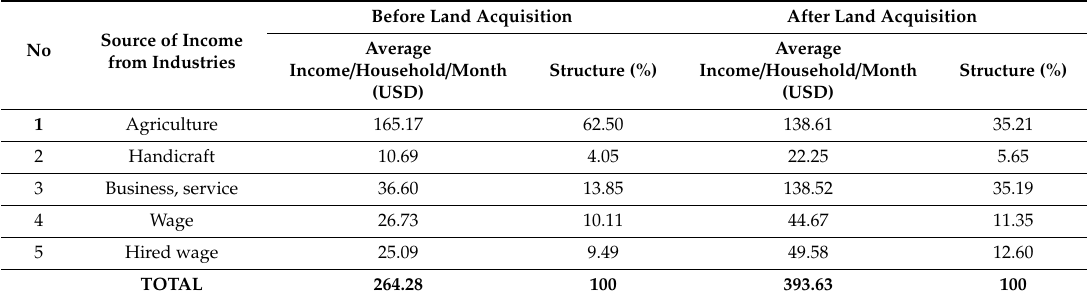
Table 4. The structure of household income.